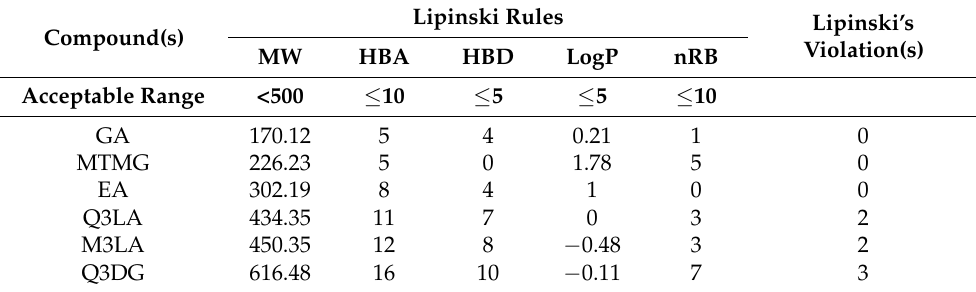
Table 5. Physicochemical properties of the six isolated compounds from W. fruticosa leaves. Lipinski Rules Compound(s)